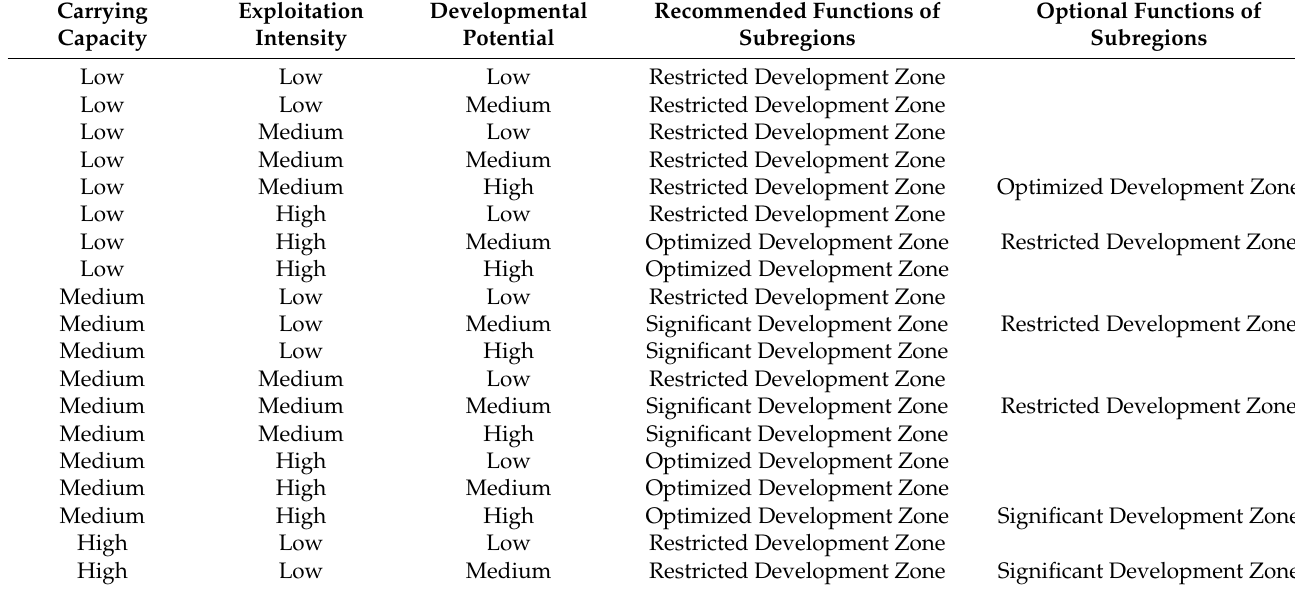
Table 4. Matrix discrimination analysis method for identifying the functions of